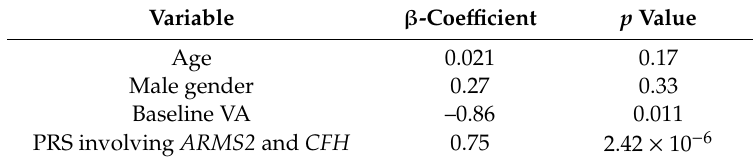
Table 5. Baseline factors associated with number of additional injections (multiple regression